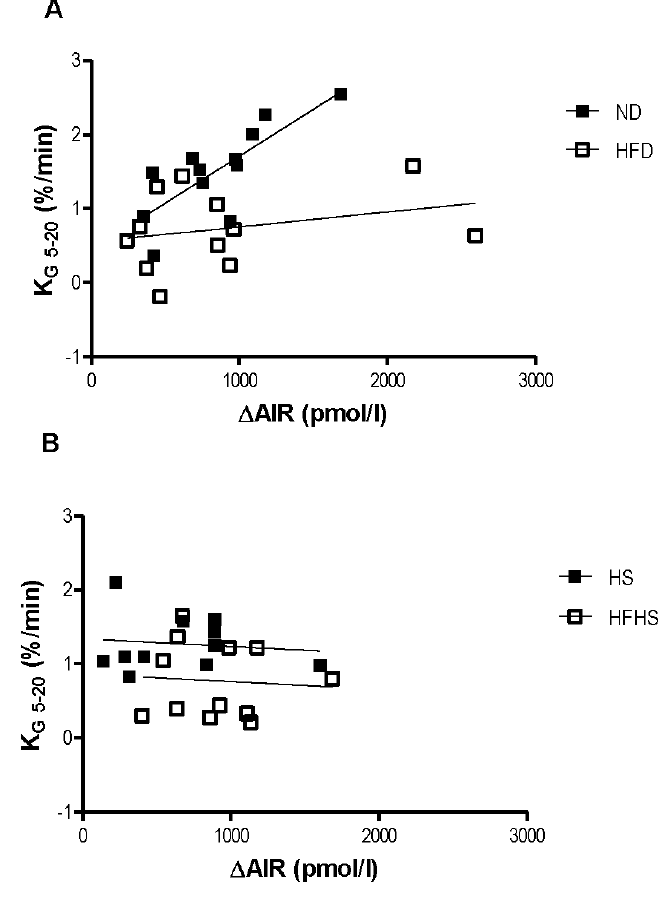
Figure 3. Relationship between insulin secretion and glucose clearance. Linear regressions between the glucose elimination rate (KG) and the acute insulin response ( Δ AIR) for the normal and high fat diet groups ( A ) and the Surwit high sucrose and high-fat high sucrose diet groups ( B ). n = 11–12 per